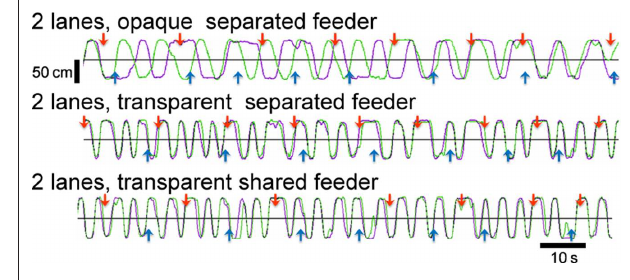
Figure 4 | representative running trajectories in the 2-lane condition (experiment 2). When separated by an opaque wall, running trajectories were not synchronized (top). When separated by a transparent wall, runs were more frequent and synchronized regardless of whether the feeder was separated (middle) or shared (bottom). All records were obtained on experimental day